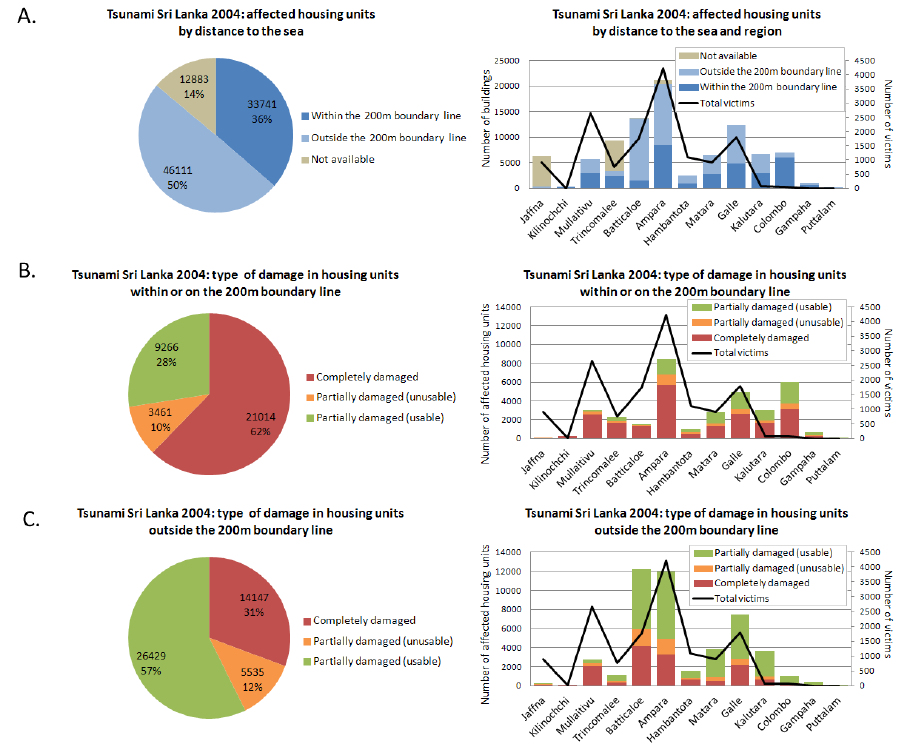
Figure 12. Correlation between number of tsunami victims, buildings’ type of damage and distance to the sea (Sri Lanka tsunami 2004).